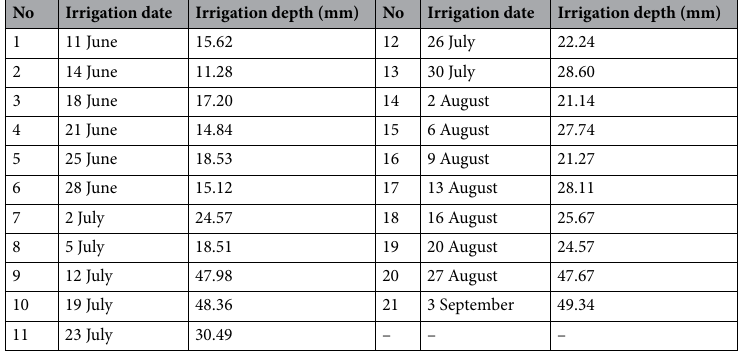
Table 3. Black gram irrigation scheduling for control treatment (I 3 ), during 2017 growing seasons.